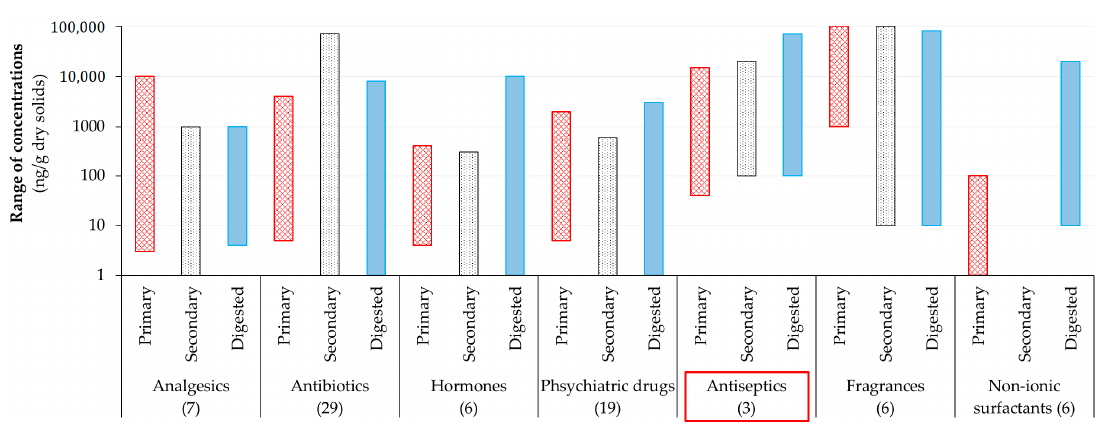
Figure 1. Occurrence of different classes of pharmaceuticals and personal care products in primary, secondary and digested sludges (the number of compounds for each class is shown in brackets). Adapted from reference [23].